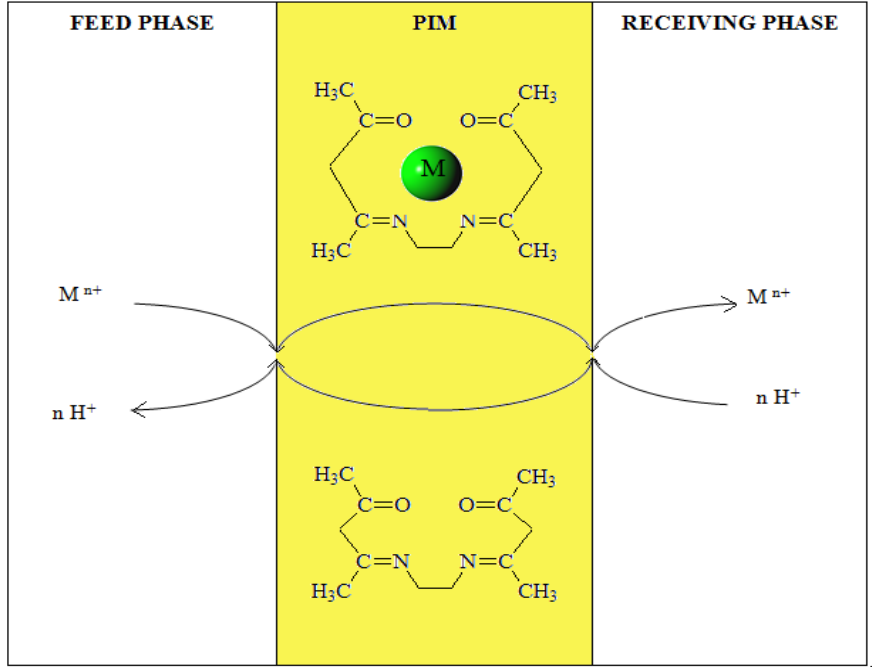
Figure 8. Schematic transport of metal ions across PIMs doped with EDAB-acac.